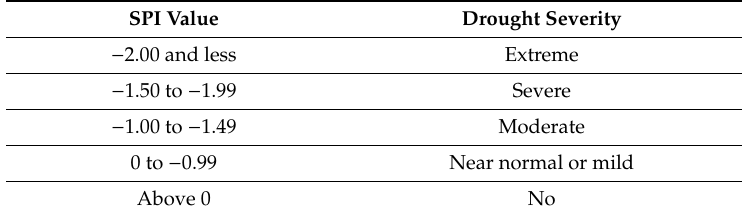
Table 2. Standardized Precipitation Index (SPI) values with different categories of drought magnitude